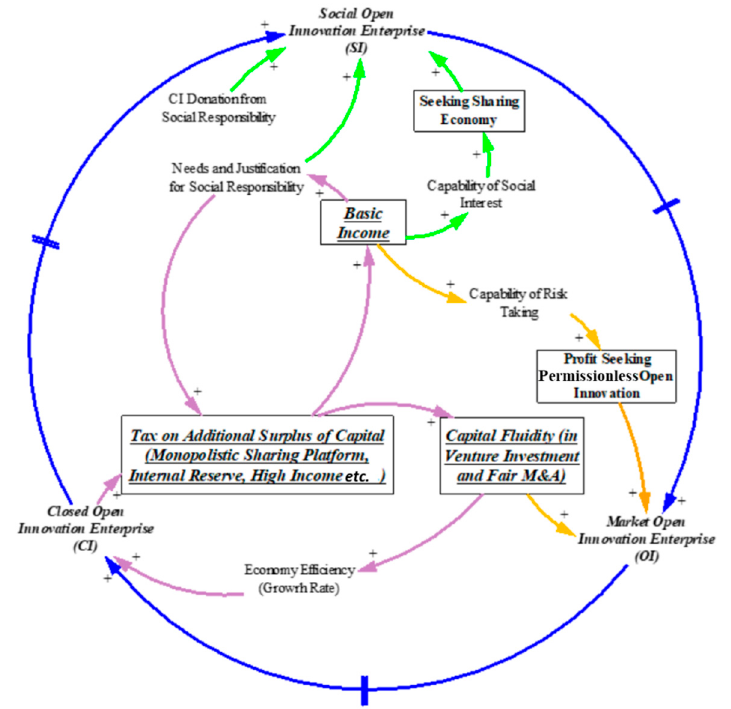
Figure 6. Causal loop modeling of government’s role in motivating open innovation dynamics.